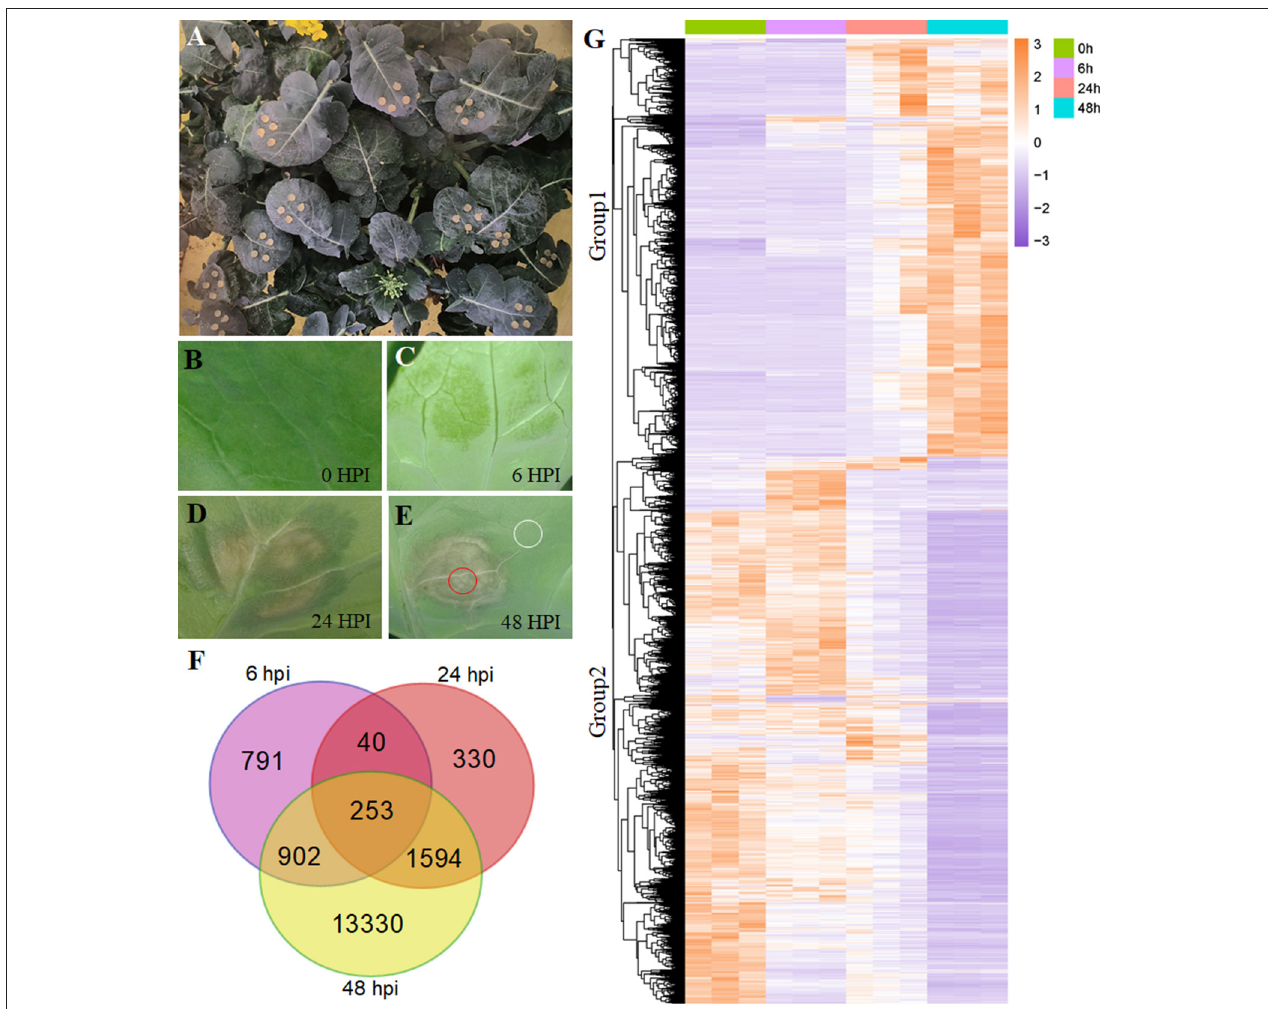
FIGURE 1 | Differentially expressed gene (DEG) analysis in Brassica napus . (A) The growing plant of B. napus at the flowering stage. (B–E) The symptoms of Sclerotinia sclerotiorum infection on B. napus leaves at 0, 6, 24, and 48 hpi. The circled areas in (E) were used in Figure 5 . (F) Overlapping and unique DEGs at the 6-, 24-, and 48-hpi stages. (G) Heatmap illustrating the hierarchical clustering results for RNA-sequencing (RNA-seq), group 1 and group 2 represent two expressed patterns. hpi, hours post-inoculation.